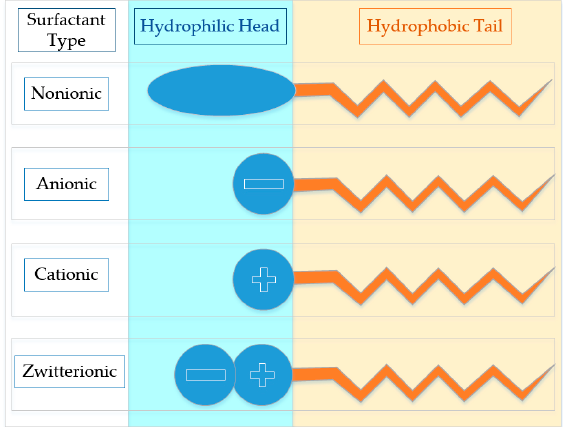
Figure 1. Surfactant classification according to the composition of their hydrophilic head.